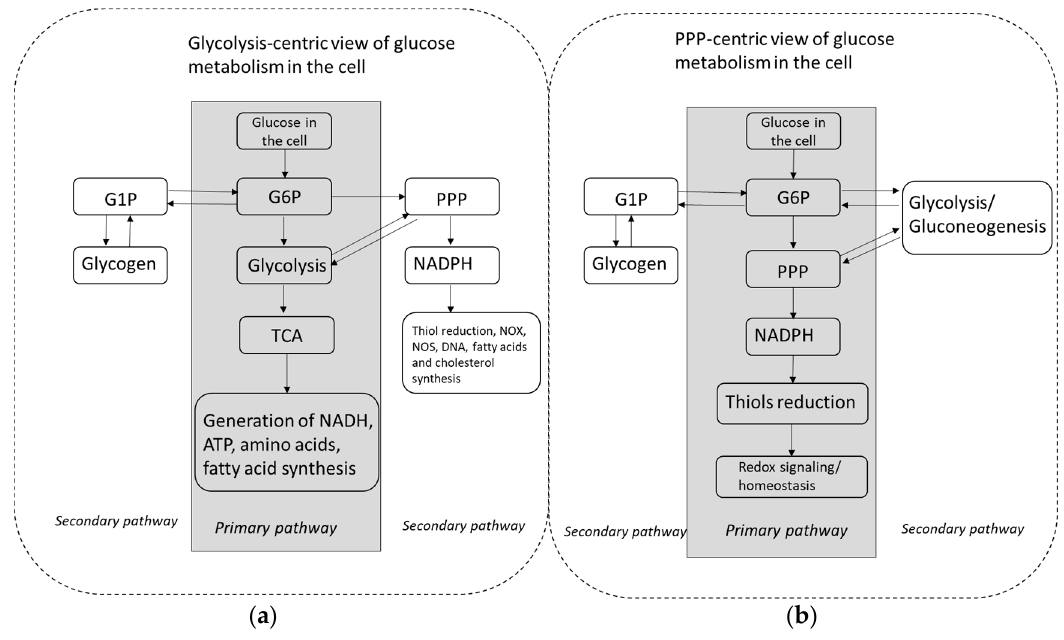
Figure 1. Schematic presentation of the conventional ( a ) and pentose phosphate pathway-centric ( b ) views of glucose metabolism. Abbreviations: G1P—glucose 1 phosphate, G6P—glucose 6 phosphate, PPP—pentose phosphate pathway, TCA—tricarboxylic acid cycle, NOX—NADPH oxidase, NOS—